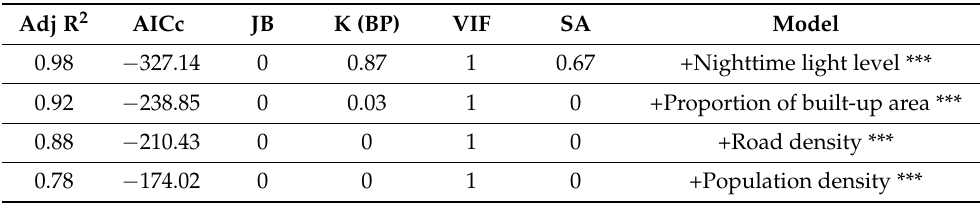
Table A4. The highest adjusted R 2 results of the explanatory regression with the SPLIT and one independent variable.